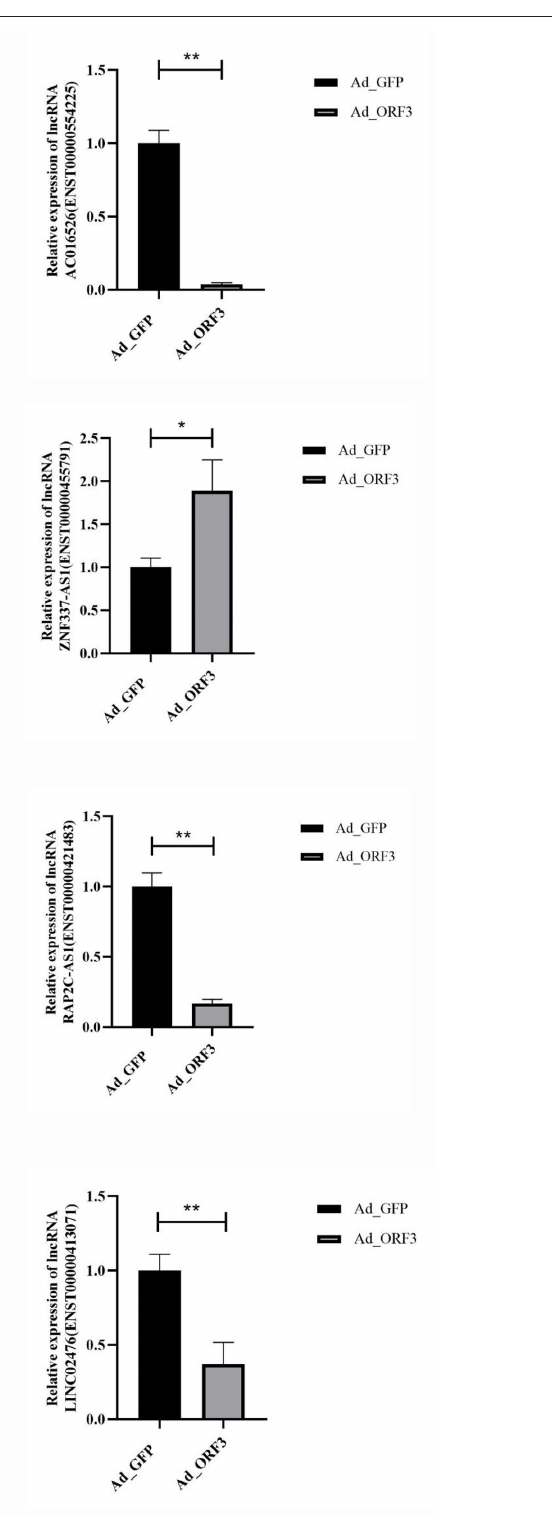
FIGURE 6 | qRT-PCR validation for the eight selected significantly differentially expressed lncRNAs. * p < 0.05, ** p < 0.01.